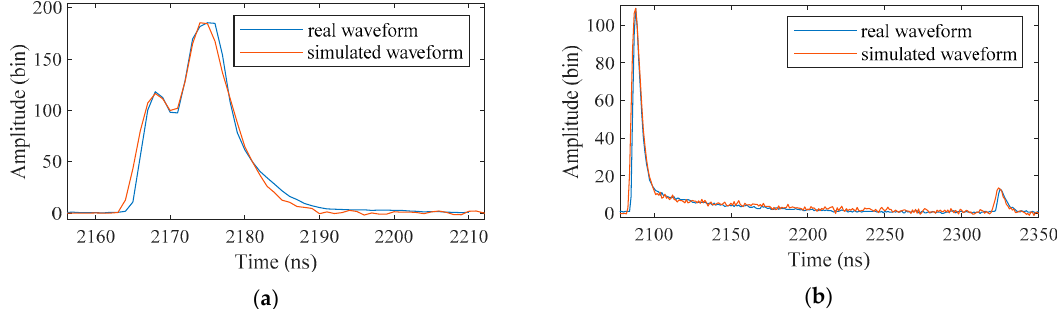
Figure 22. Comparison between the real waveforms and the simulated waveforms with depths of ( a ) 0.8 m and ( b ) 27